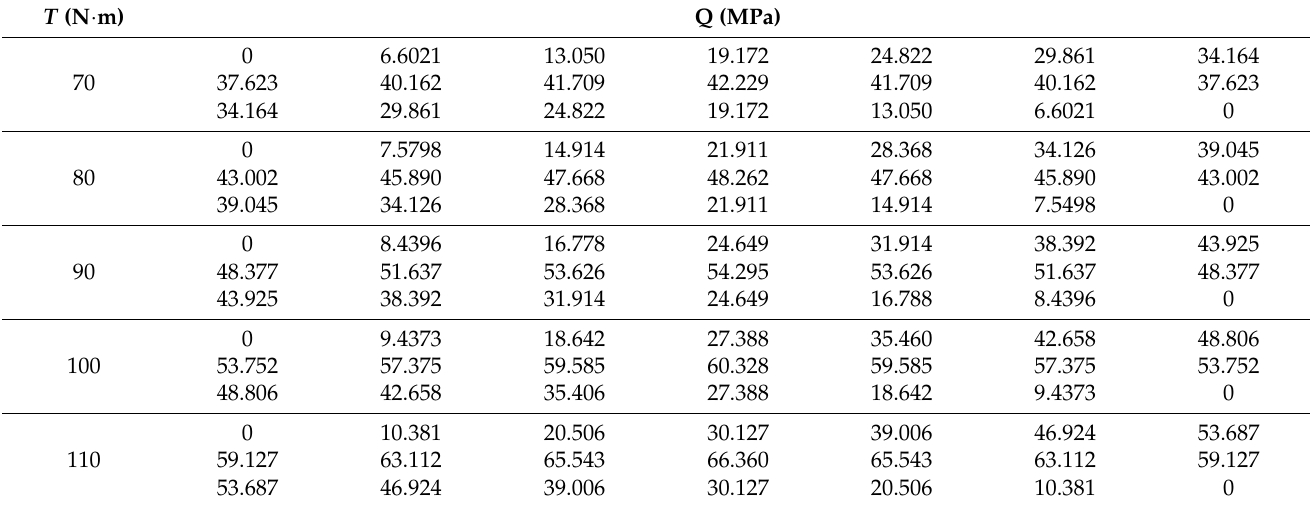
Table 1. Load value at the angle of each meshing area under different